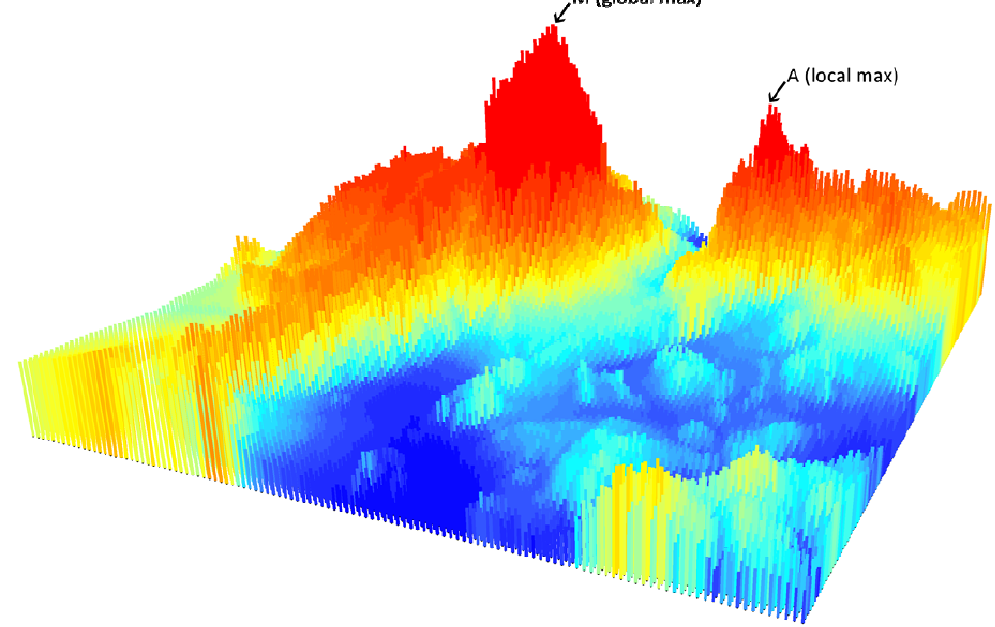
Figure 2. Hypothetical fitness landscape and outcome in the ancestral environment